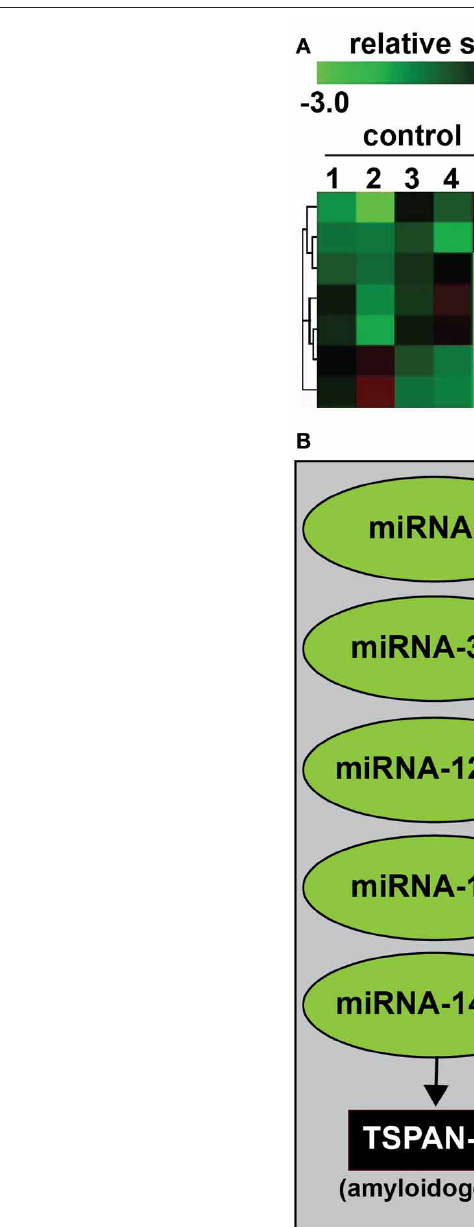
(TREM2), innate-immune signaling and chronic inflammation (IkBKG, CFH, IRAK-1, and IRAK-2), impairments in neurotransmitter packaging and